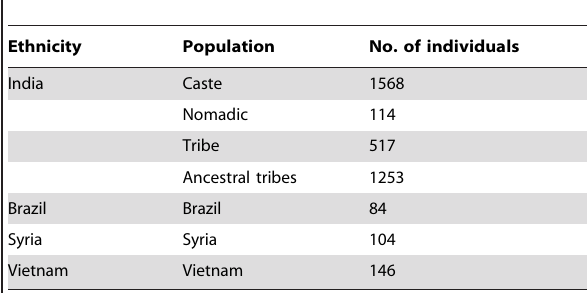
Table 2. Characteristics of studied subjects of various world